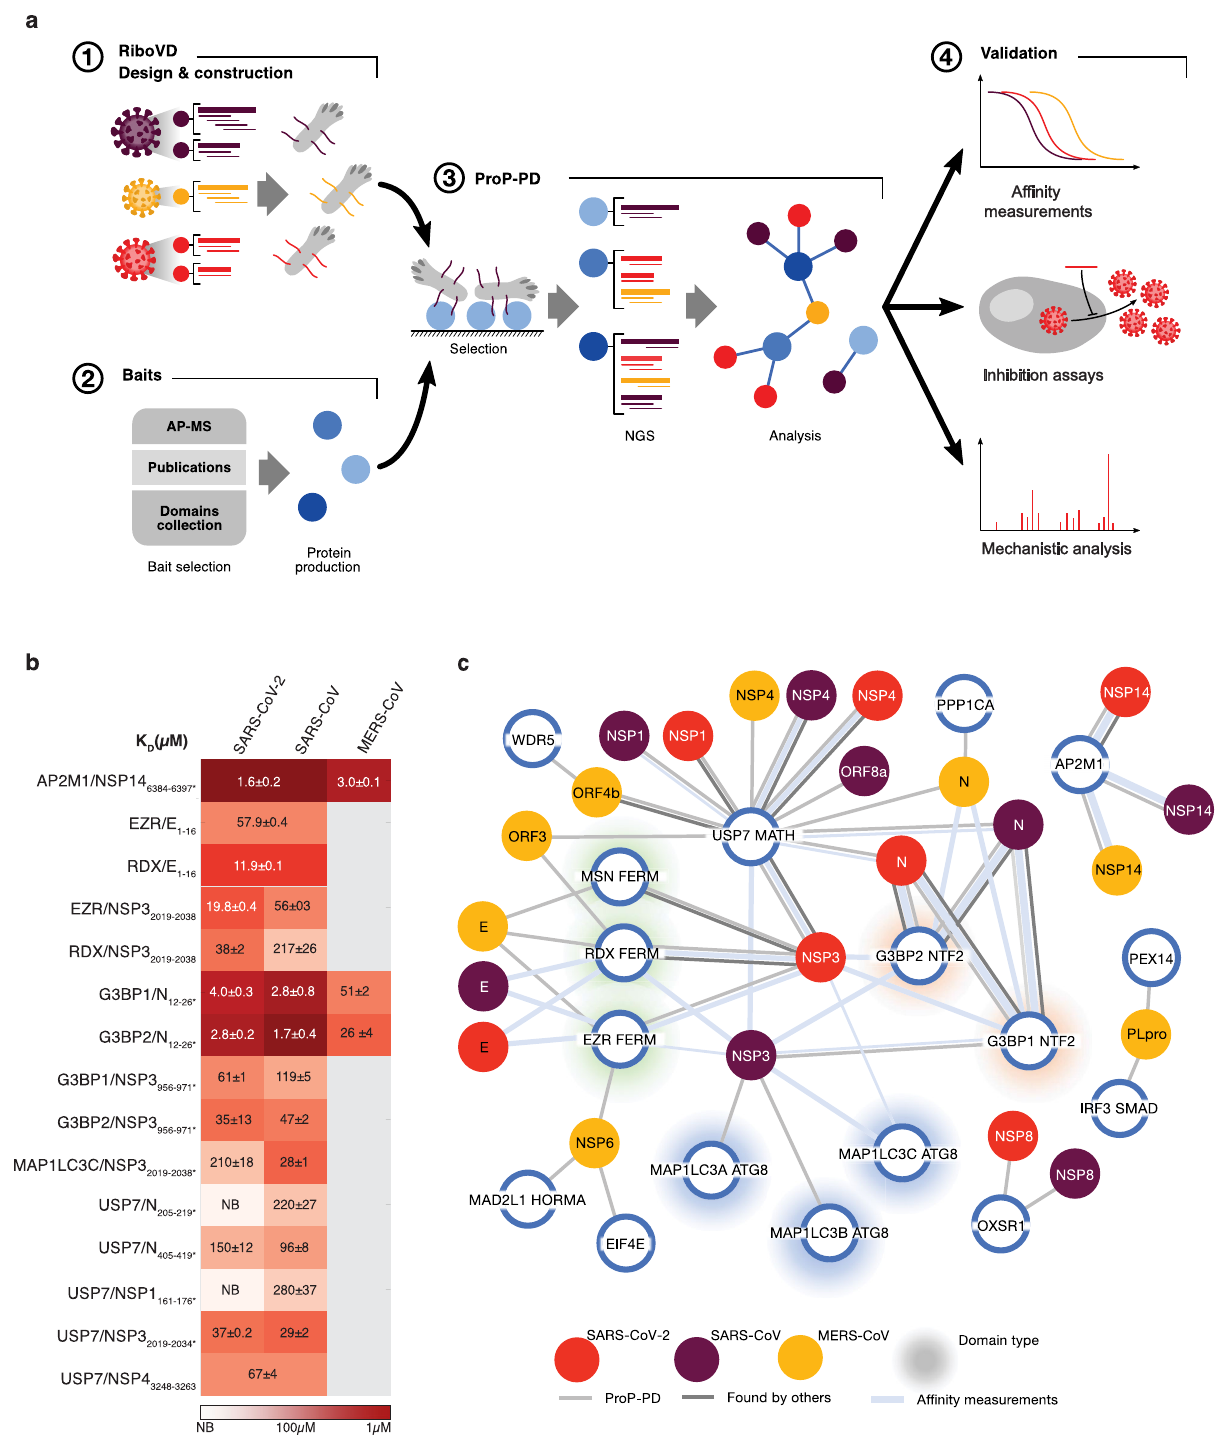
Fig. 1 A pipeline for viral SLiM discovery. a An overview of the platform for identifying viral SLiMs binding to cellular host factors. b K D values for the interactions between indicated viral peptides and host proteins. c Network of SLiM mediated interactions between the indicated viral proteins from SARS- CoV-2 (red), SARS-CoV (purple), and MERS-CoV (yellow) and cellular host factors (blue circles). Light grey connecting line indicates interactions validated by af fi nity measurements, the weight of the line represents the af fi nity of the interaction (thick, 1 – 10 μ M; medium, 11 – 100 μ M; thin, 101 – 500 μ M). Dark grey lines indicate protein-protein interactions with additional evidence found in the other studies (Supplementary Data infected with SARS-CoV-2 and viral titer determined after 16 h. mutations in the binding motif. The host proteins targeted by This revealed that the G3BP-binding peptide from the N protein viral peptides were G3BPs (SARS-CoV-2 N), Ezrin and Radixin decreased viral titer 3.4-fold (Fig. 2a). To obtain a more potent (SARS-CoV-2 E and NSP3), and the MAP1LC3s (NSP3). VeroE6 inhibition of the SARS-CoV-2 N-G3BP interaction, we used a 25 cells were fi rst transduced with the lentiviruses and 3 days later